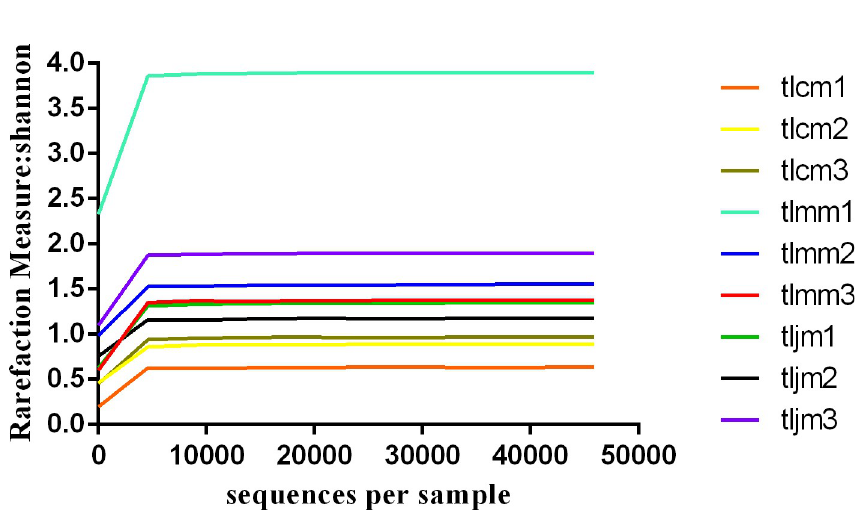
Fig 2. Rarefaction curve of the bacterial lactase gene from the intestinal mucosa in each sample. Note: The abscissa represents the number of lactase gene sequences extracted randomly; the ordinate represents the number of observed OTUs of the bacterial lactase gene. The data indicate that the sequencing tended to be saturated and that increasing the amount of data would have no significant effect on obtaining new OTUs when the curve tended to be flat; tlcm1-3, tlmm1-3, tljm1-3 are healthy control group samples 1–3, diarrhea model group 1–3 and D . hansenii treatment samples 1–3, respectively.